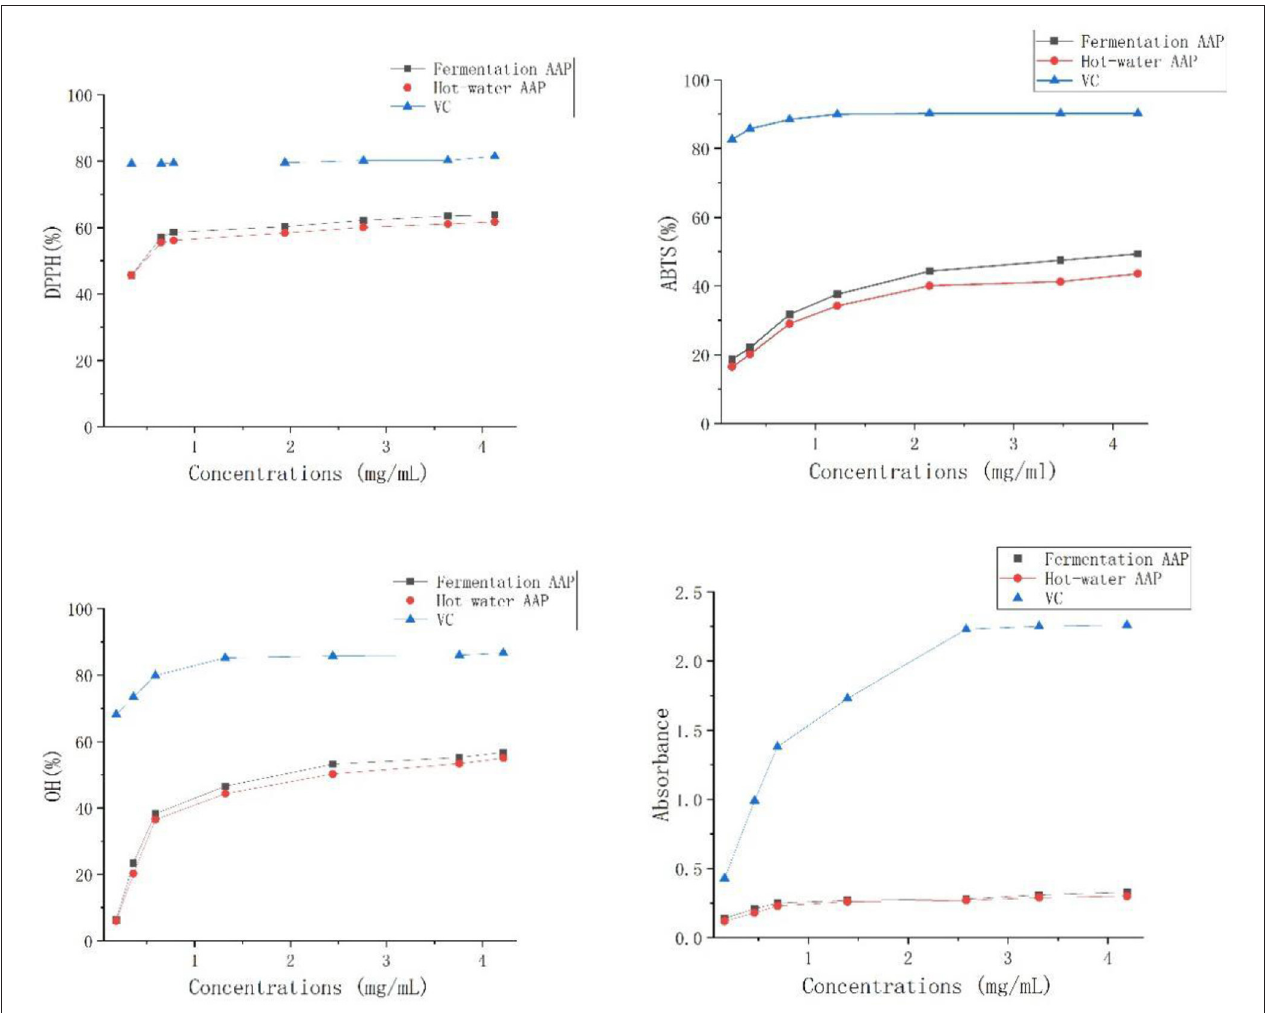
FIGURE 12 | Antioxidant activity